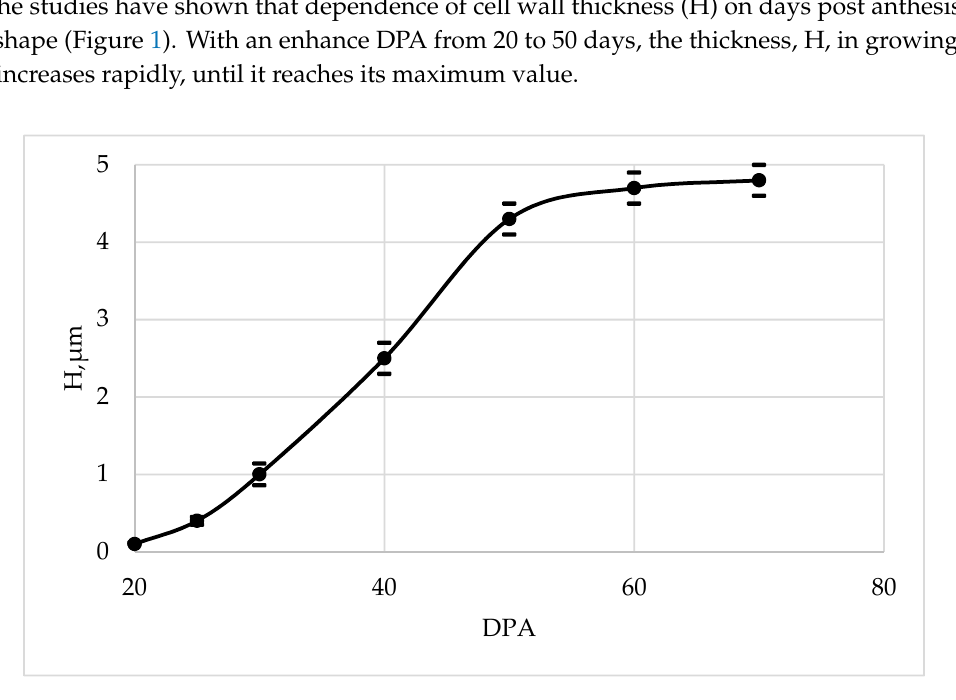
1.537 Figure 2. Linearized dependence of P on F in double logarithmic coordinates.